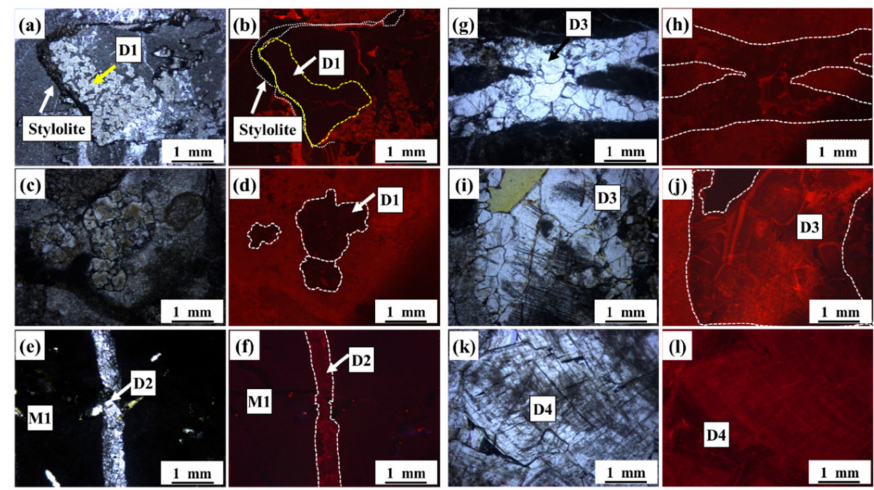
Figure 4. Thin section and the cathodoluminescence photomicrographs showing different kinds of dolomite cements in the Lower Paleozoic strata in the Dongying Depression, Bohai Bay Basin. ( a ) The powder-to-fine-crystalline dolomite cements (D1) along with the stylolite, Well Bg11 2449.5 m, Ordovician formation, plane-polarized light; ( b ) characteristics of cathodoluminescence in the same field of view as a. The powder-to-fine-crystalline dolomite cements within the yellow dotted line, CL; ( c ) the powder-to-fine-crystalline dolomite cements (D1) filled in the oolite and have the characteristics of “mist core bright edges”, Well Bg26 2795.5 m, Zhangxia formation, plane-polarized light; ( d ) the powder-fine-crystalline dolomite cements (D1) filled in the oolite within the white dotted line. The powder-fine-crystalline dolomite cements (D1) filled in the oolite in the same field of view as c, within the white dotted line, CL; ( e ) fractures developed in the microcrystalline dolomite (M2), which were filled in with fine-crystalline ferroan dolomite cements (D2), Well Bg22 2233.04, Ordovician formation, plane-polarized light; ( f ) characteristics of cathodoluminescence in the same field of view as e, and there are fine-crystalline ferroan dolomite cements (D2) in the white dotted line showing the weak dark red cathodoluminescence characteristics, CL; ( g ) the medium-to-coarse-crystalline dolomite cements (D3) filled in the fractures, Well Bg26 2801.9 m, Zhangxia formation, plane-polarized light; ( h ) characteristic of cathodoluminescence of the medium-to-coarse-crystalline dolomite cement (D3) filled in the fractures in the same field of view as g, and showing the weak cathodoluminescence,